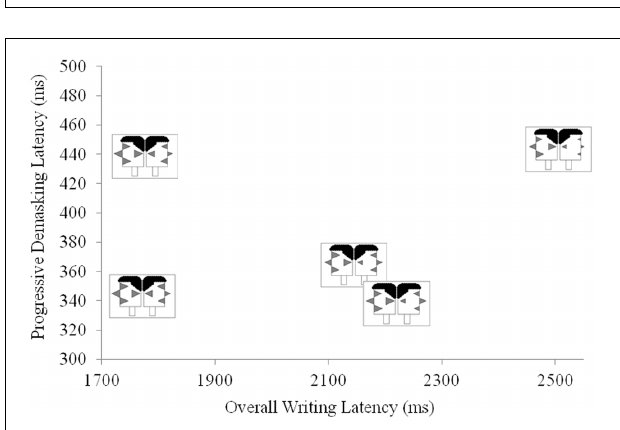
FIGURE 11 | Using Janus facial profiles to code individuals’ first and second language abilities and their relations to on-line performance in a P3 experiment.